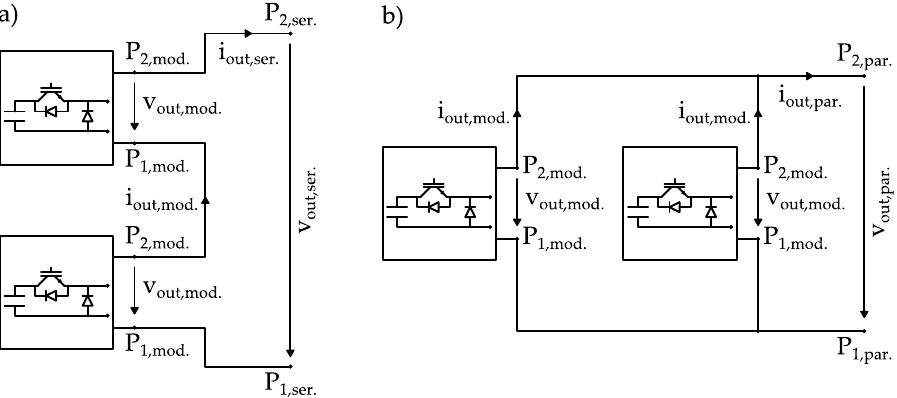
Figure 5. Interconnection options of individual PEBC modules in ( a ) serial and ( b ) parallel intercon- nection.